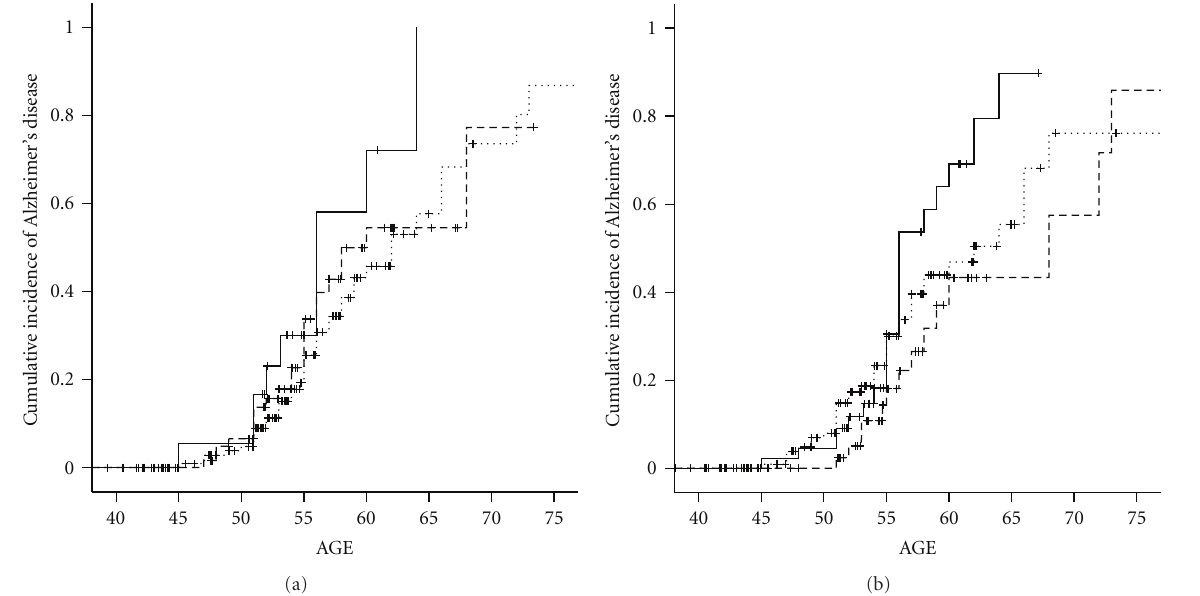
Figure 2: (a) Cumulative incidence of Alzheimer’s disease by HSD17B1 rs598126 genotype in women with Down syndrome. TT - - - -.